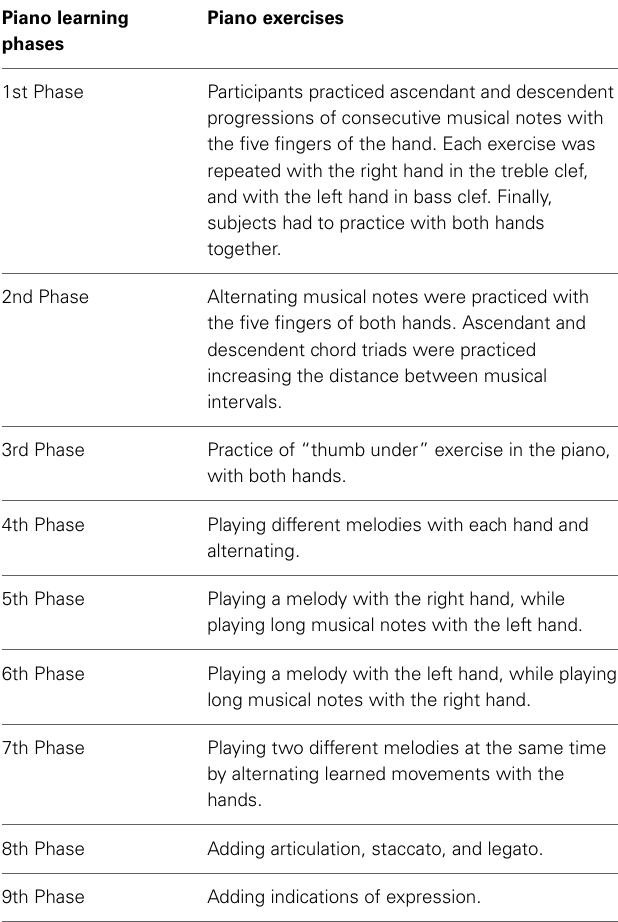
Table 2 | Piano learning phases and their gradual increase in